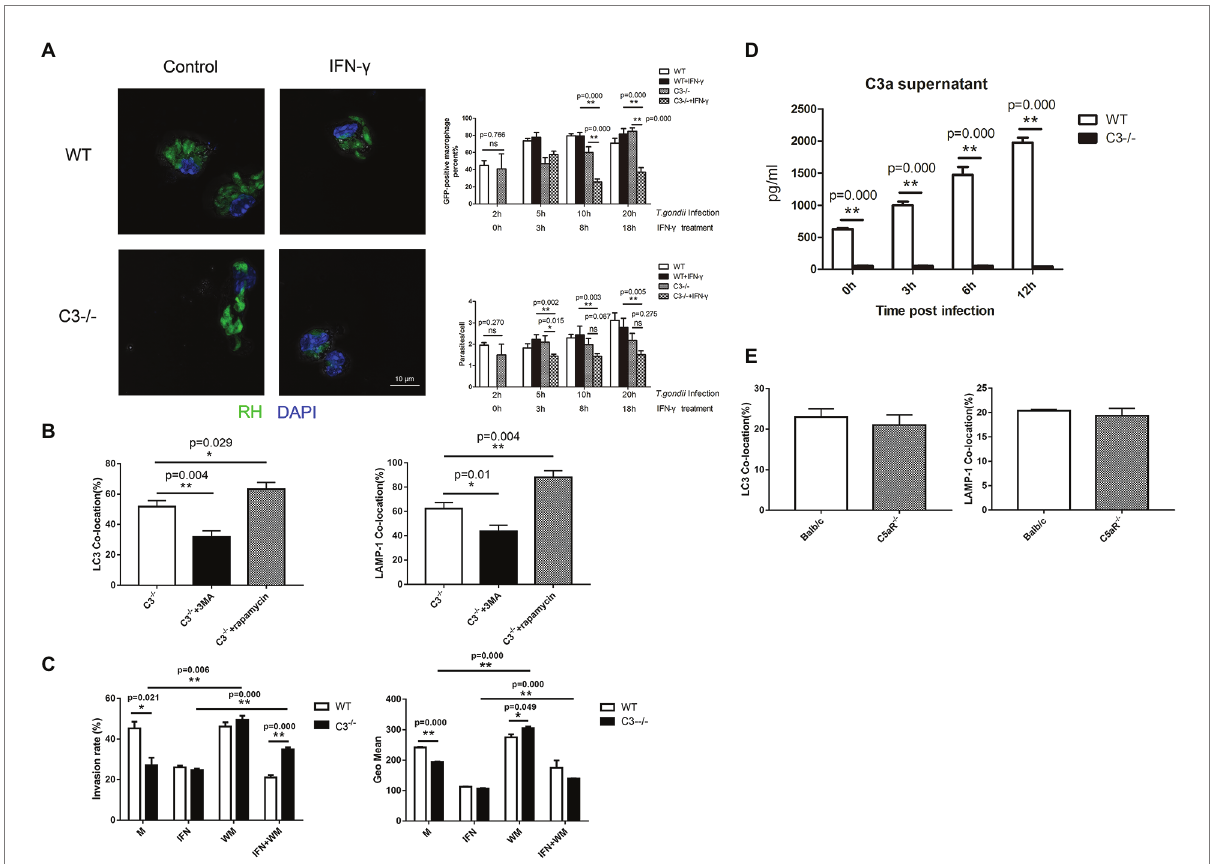
FIGURE 3 Macrophage autophagy induced by complement C3 Knock-out helps IFN- γ remove T. gondii . (A) Laser confocal microscopy is used to observe the killing of T. gondii by IFN- γ -pretreated macrophages from WT and C3 − / − mice. RH-EGFP T. gondii appears green fluorescence and the macrophage nucleus is stained with DAPI (blue fluorescence). Count the number of the GFP-positive macrophages (n 1 ) and the number of T. gondii in the GFP-positive macrophages (n 2 ) in 100 macrophages. The GFP-positive macrophages (%) = n 1 %; parasite/cell = n 2 /n 1 . T. gondii was co- cultured with macrophages from C3 − / − and WT mice for 2, 5, 10, and 20 h respectively, in different experimental groups. IFN- γ was added after 2 h of the co-culture of T. gondii and macrophages on each group. The horizontal axis represents the the time for the treatment. Scale bars, 10 μ m. WT, wild-type mice’ macrophages; C3 − / − , macrophages from C57BL/6 J mice with C3 knock-out; WT + IFN- γ , wild-type mice’ IFN- γ -activated macrophages. C3 − / − + IFN- γ , IFN- γ -activated macrophages from C57BL/6 J mice with C3 knock-out. (B) Laser confocal microscopy is used